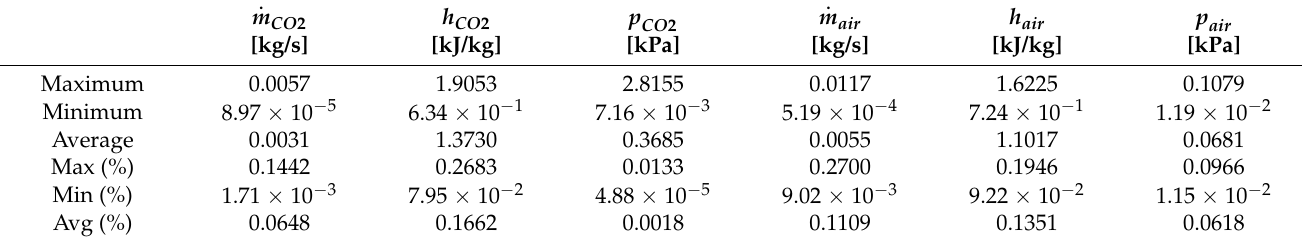
Table 7. Performance (absolute and relative errors) per output parameter for the PINN model of the heat exchanger network that used the hybrid Adam-TNC